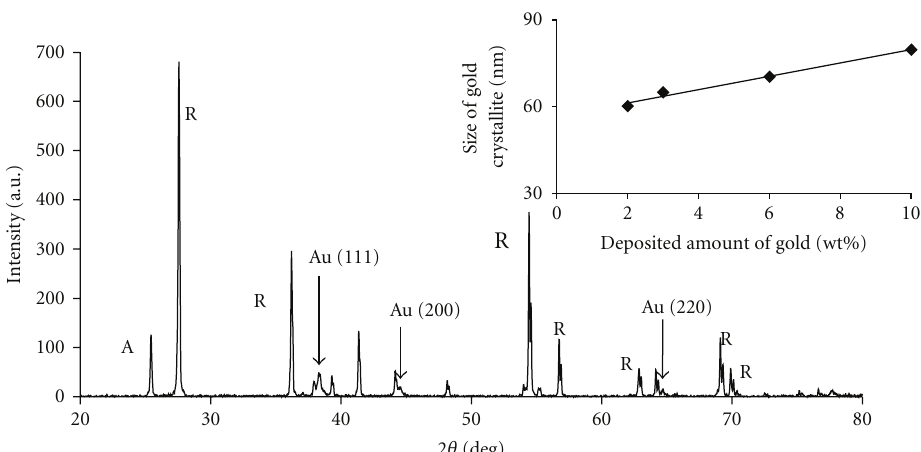
Figure 8: An XRD pattern of Au/TiO 2 : Aldrich R: A-anatase, R-rutile, Au-gold. Inset. Dependence of gold crystallite size (determined for Au 111) on deposited amount of gold.